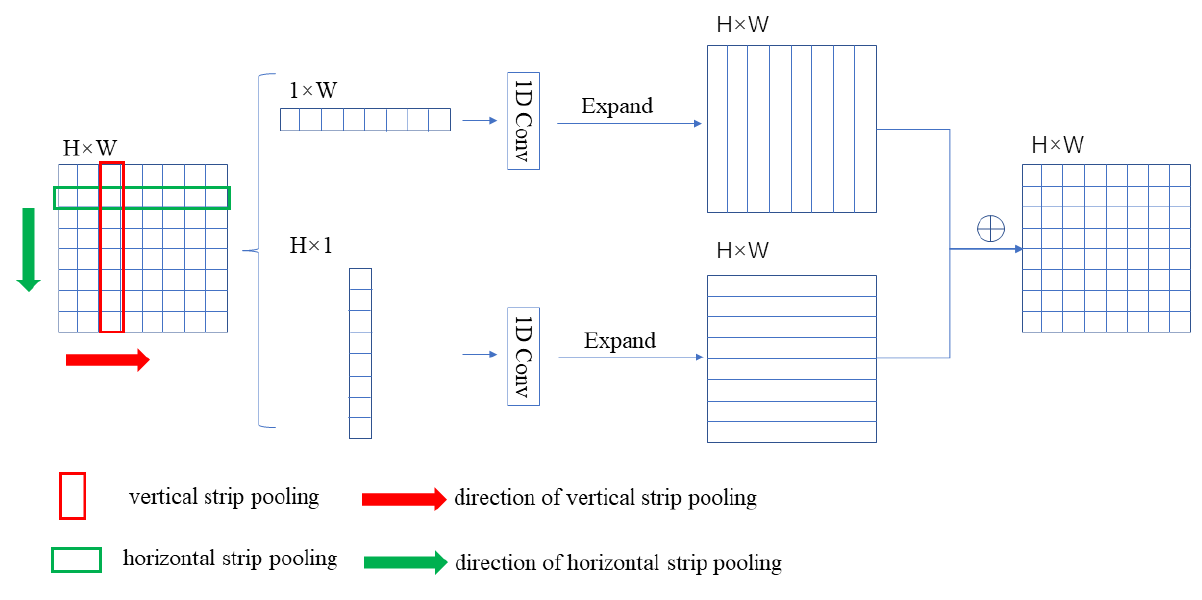
Figure 2. Illustration of strip pooling.